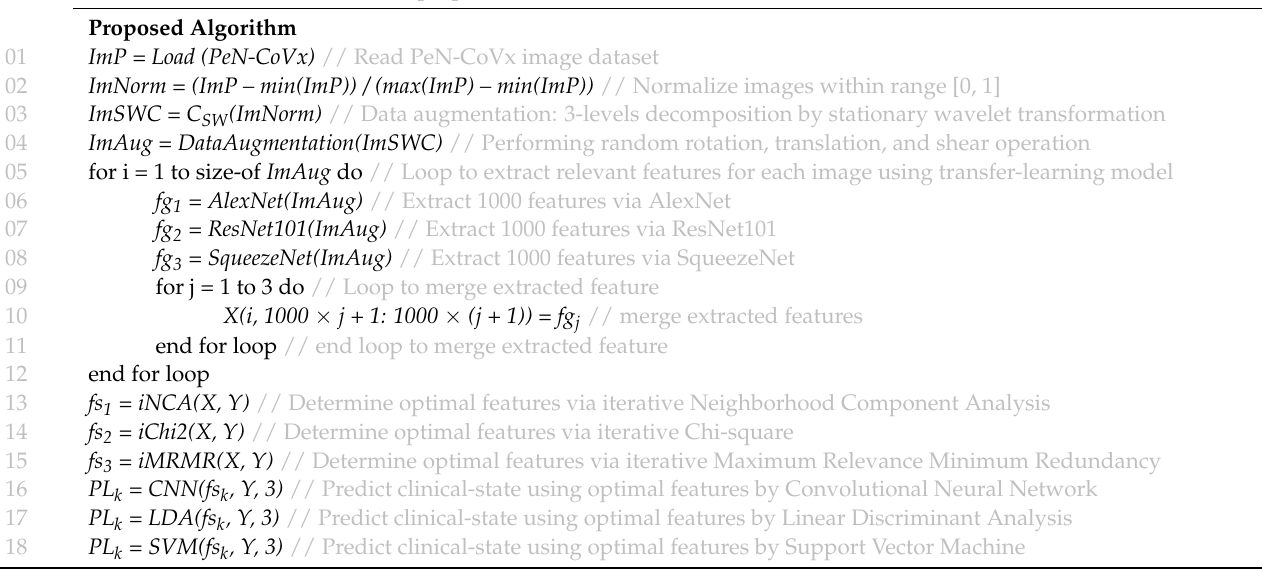
Algorithm 1. Pseudo code of the proposed scheme. Proposed